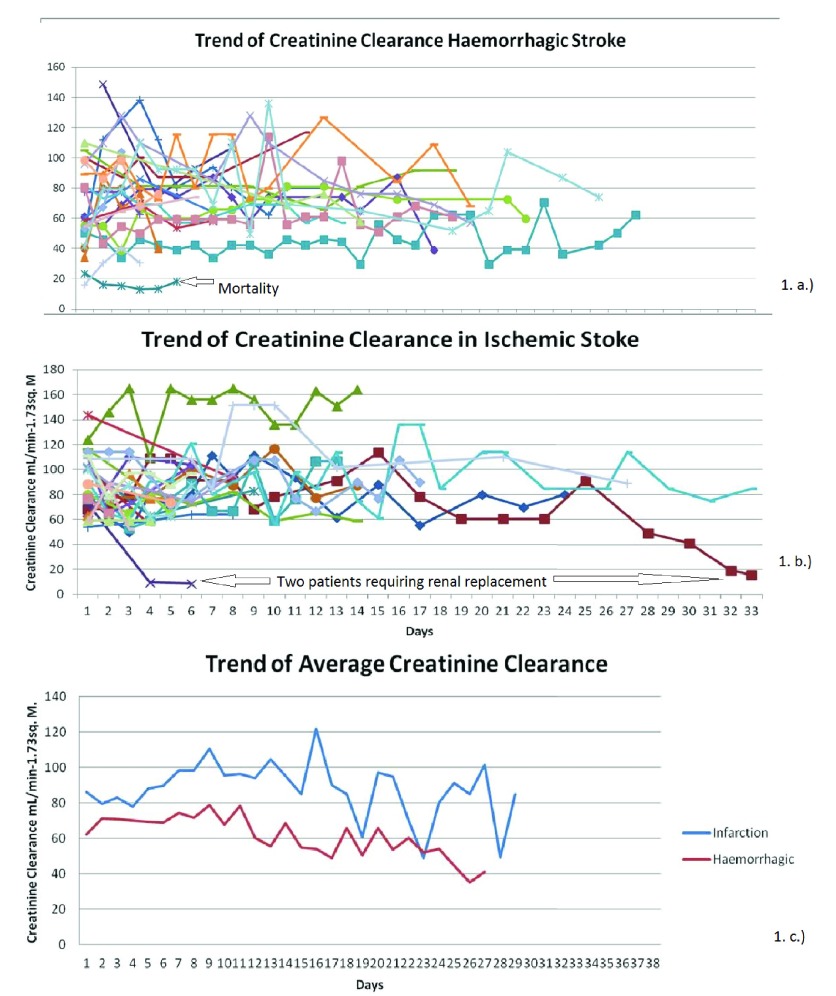
Trends of e-GFR in patients with (
A) hemorrhagic and (
B) ischemic stroke. (
C) Trend of average e-GFR.